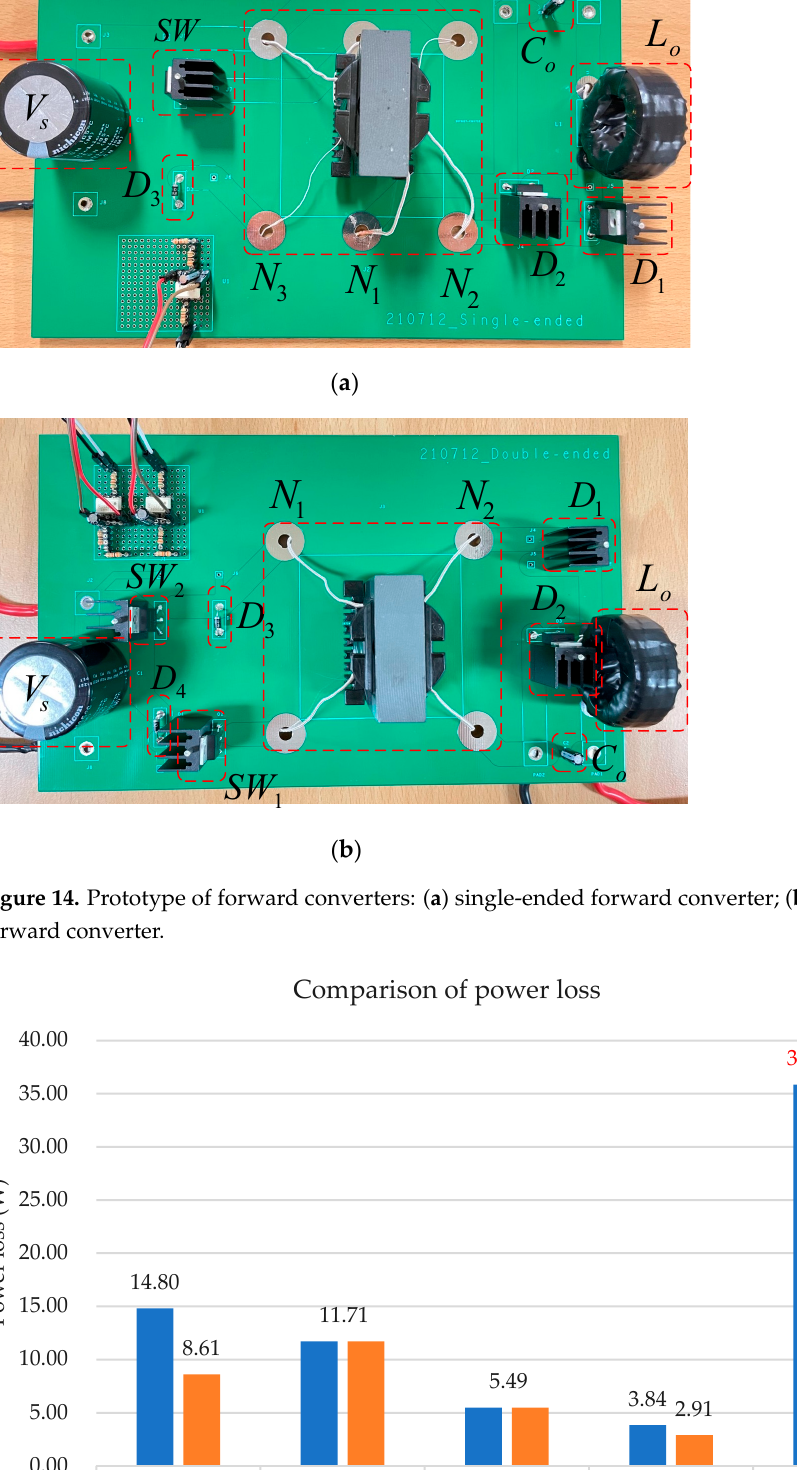
Figure 14. Prototype of forward converters: ( a ) single-ended forward converter; ( b ) double-ended forward converter.